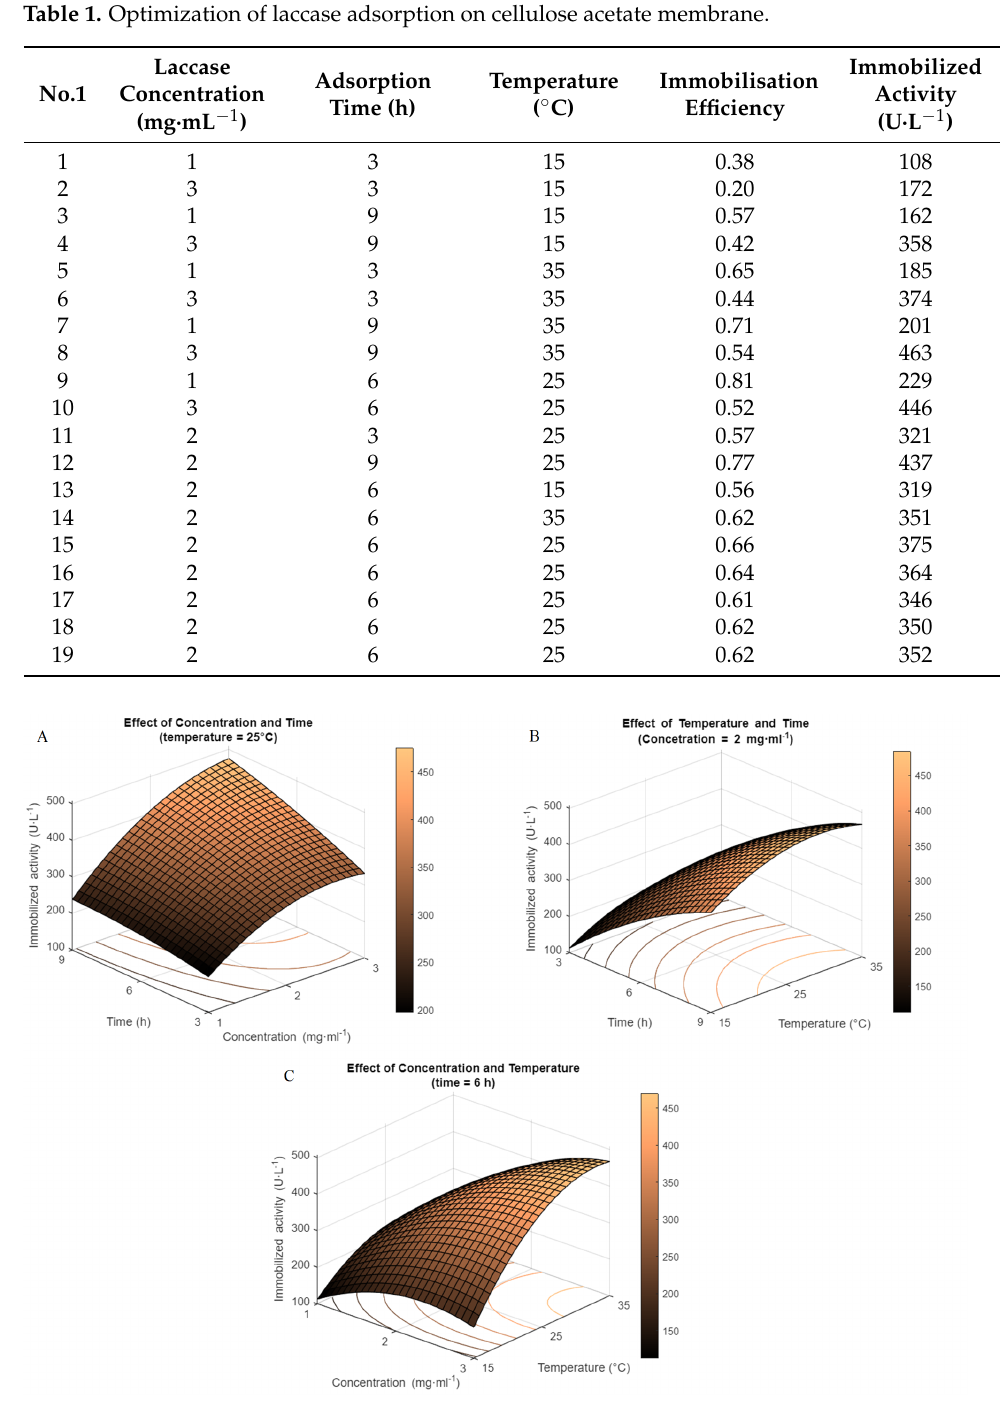
Figure 3. Effect of parameters on enzyme adsorption. Visual representations were based on the polynome fitted to our results with one of the three parameters fixed as indicated above each surface plot. ( A ) Effect of concentration and time with temperature fixed at 25 ◦ C, ( B ) Effect of temperature and time with concentration fixed at 2 mg·mL − 1 ( C ) Effect of concentration and temperature with time fixed at 6